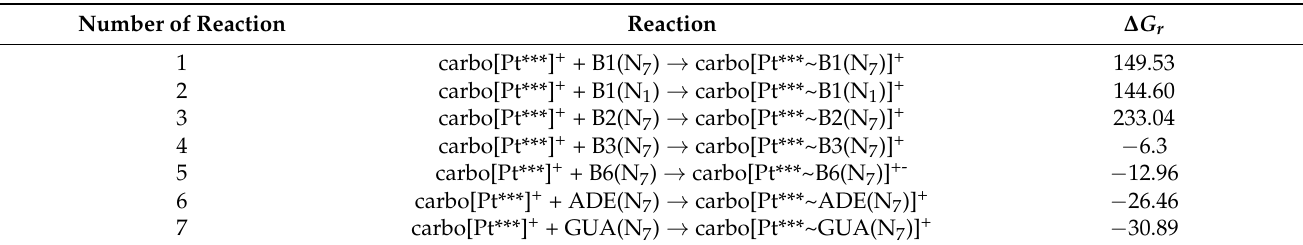
Table 3. The energetic characteristics of the ([Pt(NH 3 ) 2 (OH)] + ) reactions with derivatives of vitamin B. All energies are given in kcal/mol. Symbol Pt*** stands for Pt(NH 3 ) 2 (OH). Number of Reaction